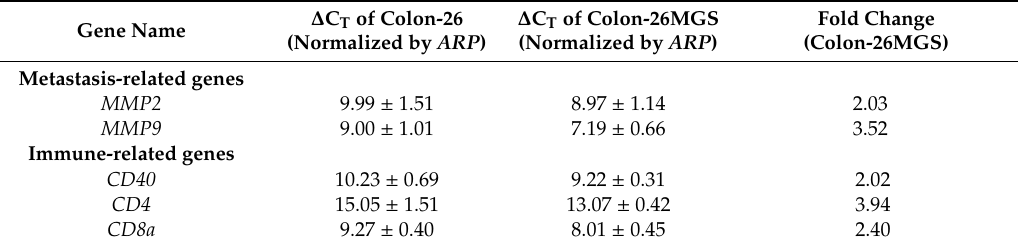
Table A4. Gene expression of transplanted tumors by qRT-PCR.